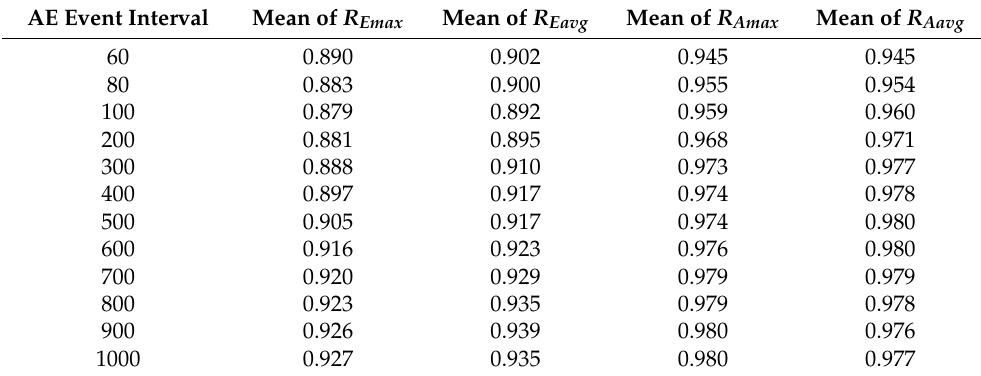
Figure 7. b value and stress vs. time under different true triaxial stresses. The range of b values is between 0.85 to 2.62. Table 2. The mean of R 2 at different AE event count intervals for specimen